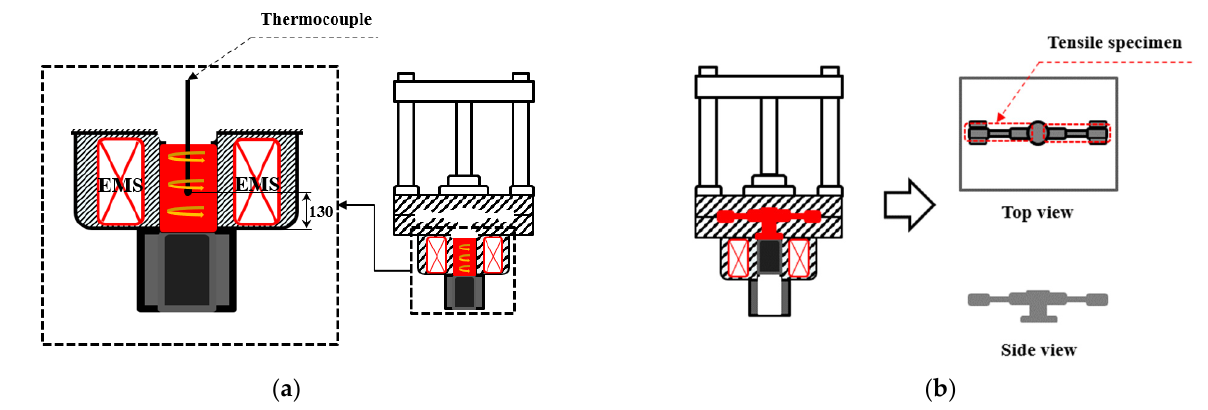
Table 2. Experiment conditions in EMS process.